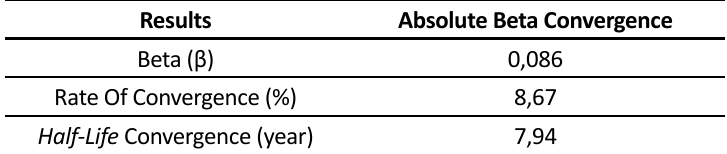
Table 2: Absolute Beta Convergence Speed in South Kalimantan in